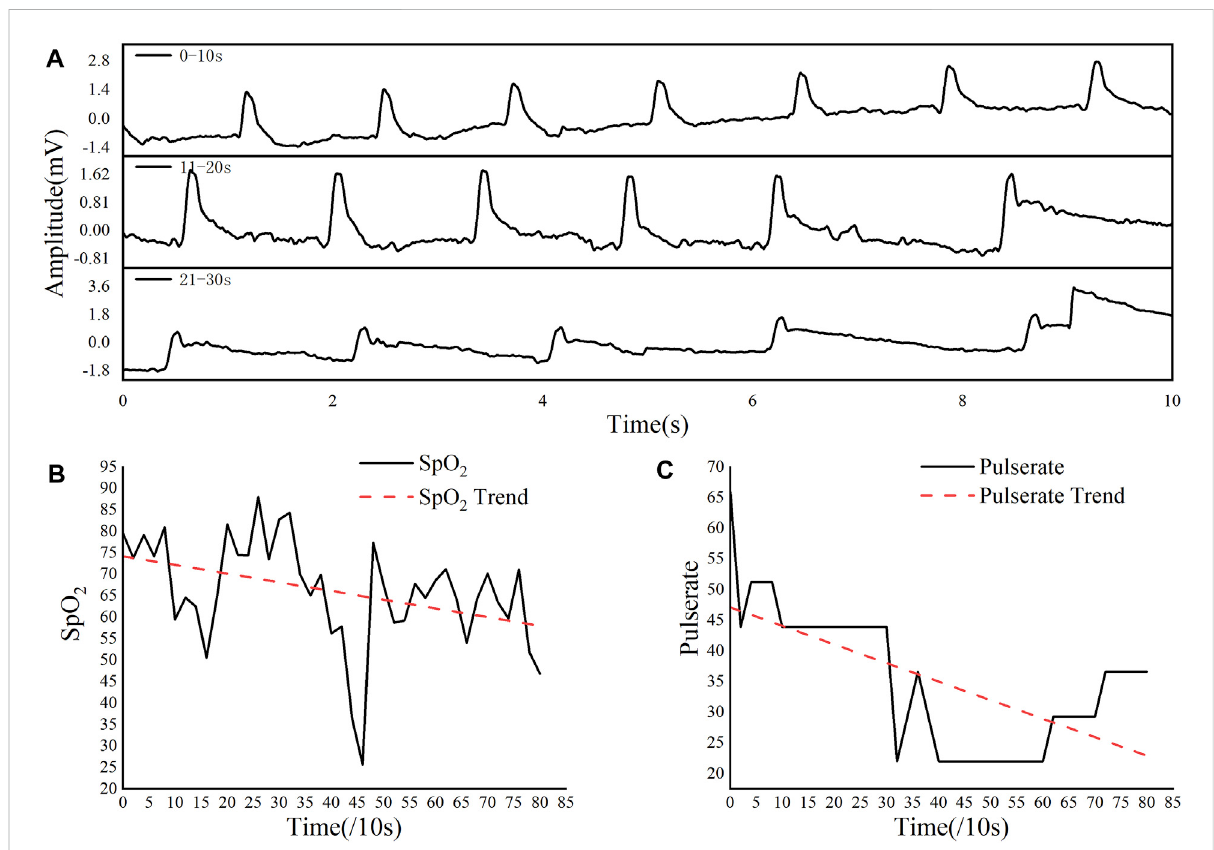
FIGURE 3 Red light PPG of the rat brain in the fi rst 90 s. (A) The intensity of the red light re fl ected every 10 s. (B) The change of blood oxygen saturation gradually decrease. (C) Pulsation gradually decrease. Variation and analysis of Time-frequency energy spectrum